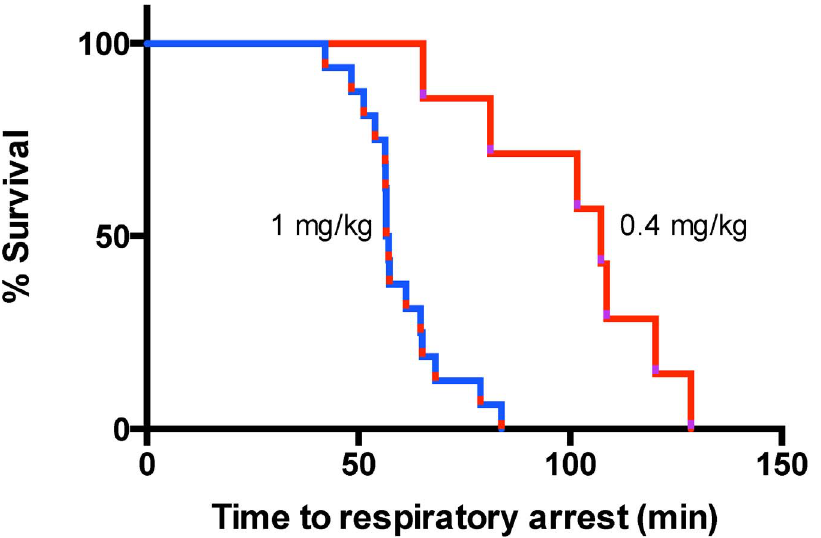
Figure 3. Effect of Ptx venom dose on the time to respiratory arrest consequent to hind foot injection in urethane anaesthetized rats.